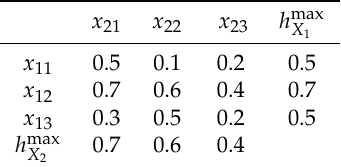
Table 4. Specification of a function h ( x 1 i , x 2 j ) and its marginals using the max t-conorm.